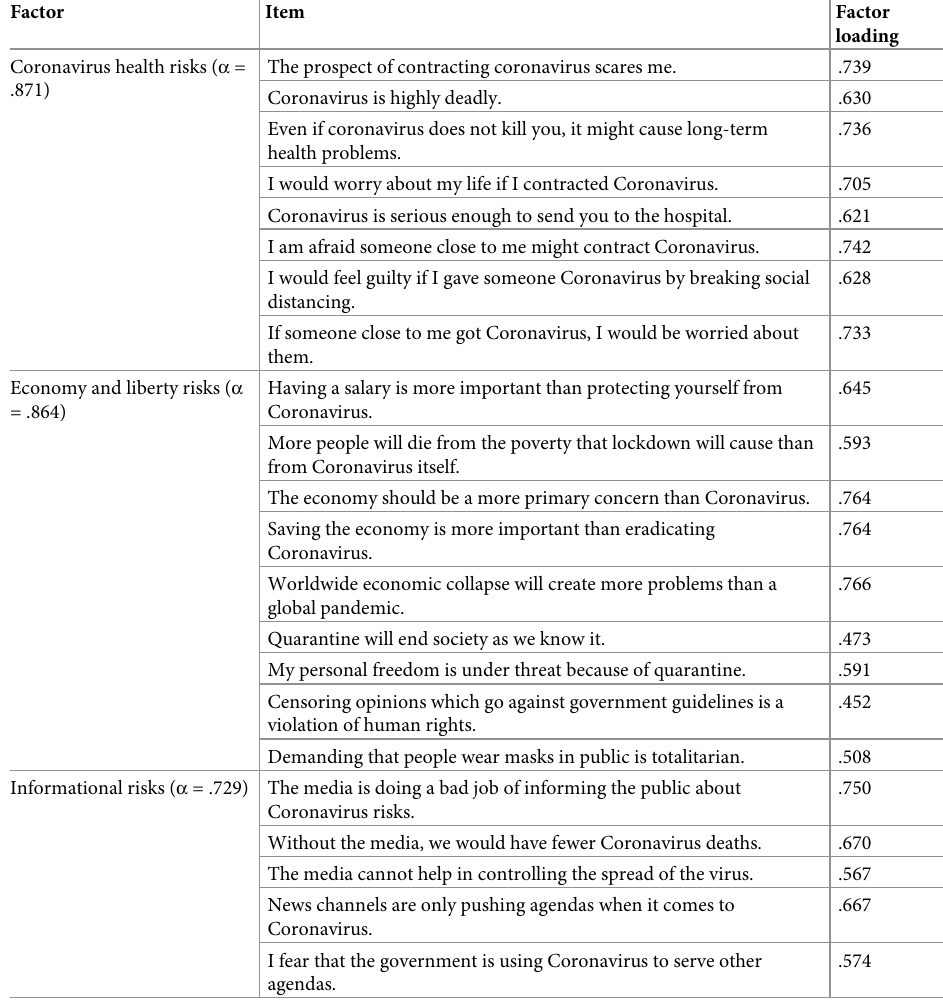
Table 1. Risk perception sub-scales with final factor